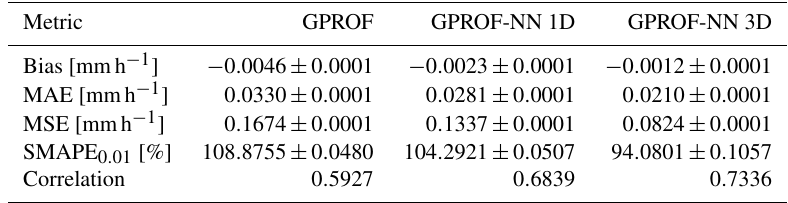
Table C5. The same as Table 5 but for convective precipitation.